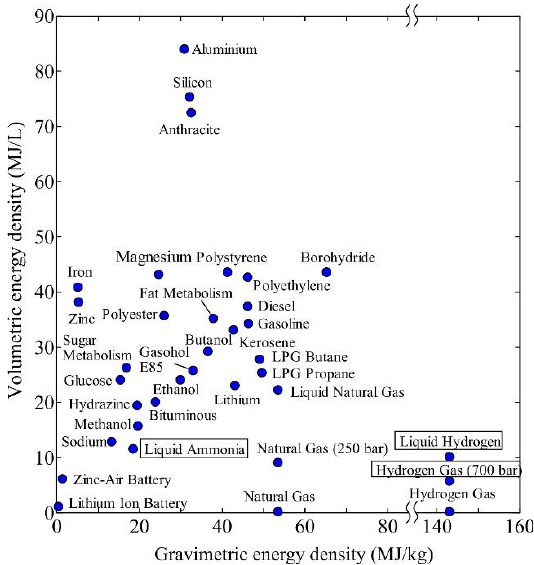
Figure 3. Gravimetric and volumetric energy densities of metals compared with organic combustible materials and batteries. Source: Kobayashi et al. [55].